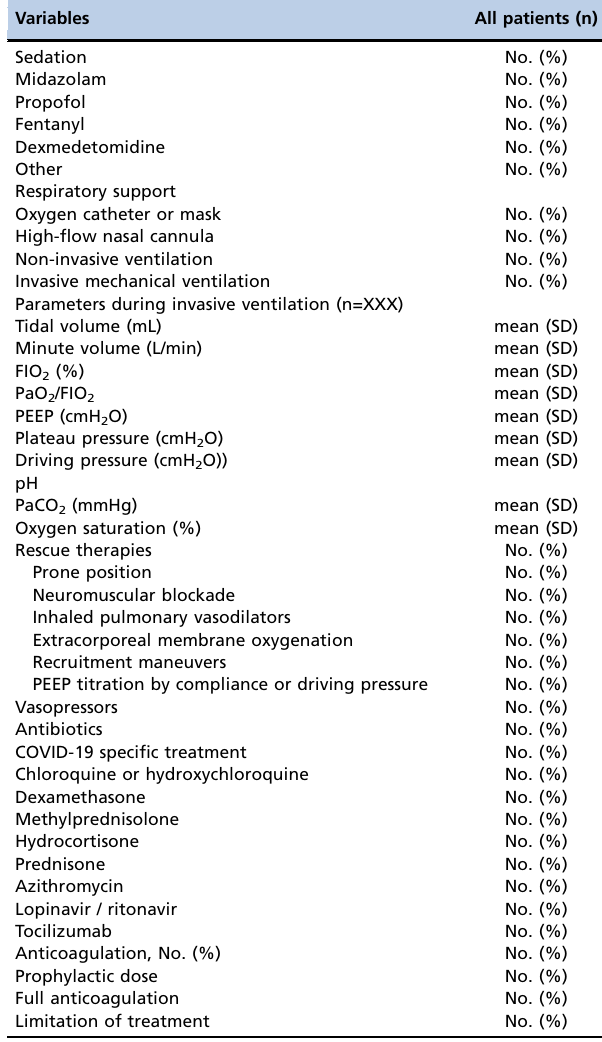
Table 3 - Patient management on day 1 after ICU